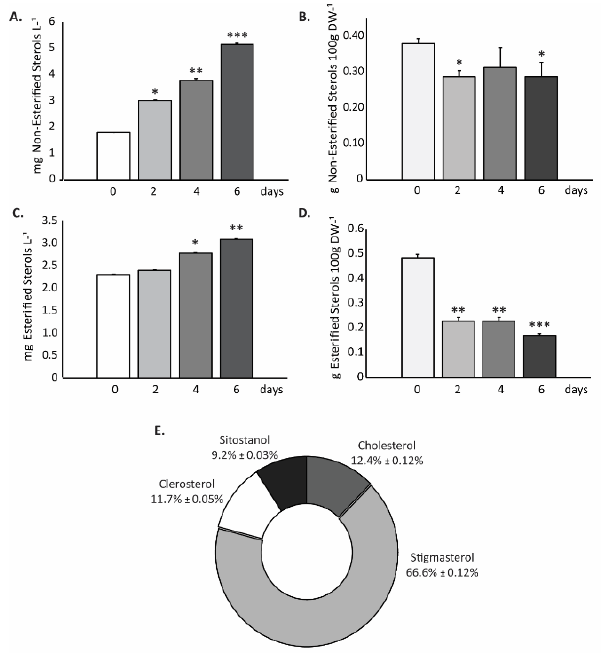
Figure 3. Sterol production and composition of H. coffeaeformis . Non-esterified ( A ) and esterified ( C ) sterols (shown as mg of sterols L − 1 ). Non-esterified ( B ) and esterified ( D ) sterols expressed in terms of biomass (g 100 g · DW − 1 ). E) Sterols detected in H. co ff eaeformis at day 6 (expressed as % of total sterols). In the graphics, average values ± standard deviation are indicated (n = 3). * stands for statistically significant (p < 0.05), ** highly significant (p < 0.01) or *** very highly significant di ff erences (p < 0.001) between conditions,